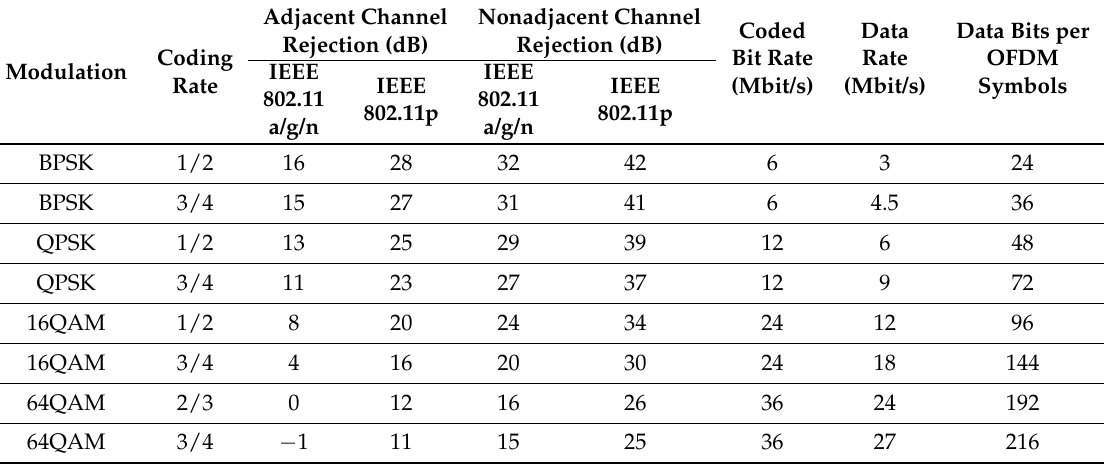
Table 3. Transmission rates and channel rejection comparison.